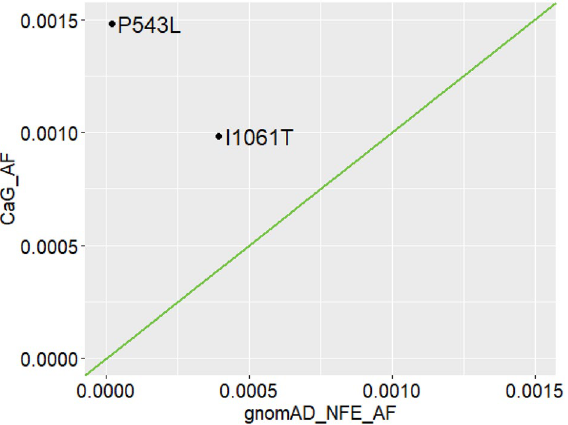
Figure 1. Comparison of variant allele frequencies (AF) in the CARTaGENE cohort compared to gnomAD NFE. The AF of the two identified pathogenic variants, P543L and I1061T is plotted in the CaG cohort (CaG_ AF) as a function of the allele frequency in gnomAD NFE (gnomAD_NFE_AF). Made with the ggplot package in R (version